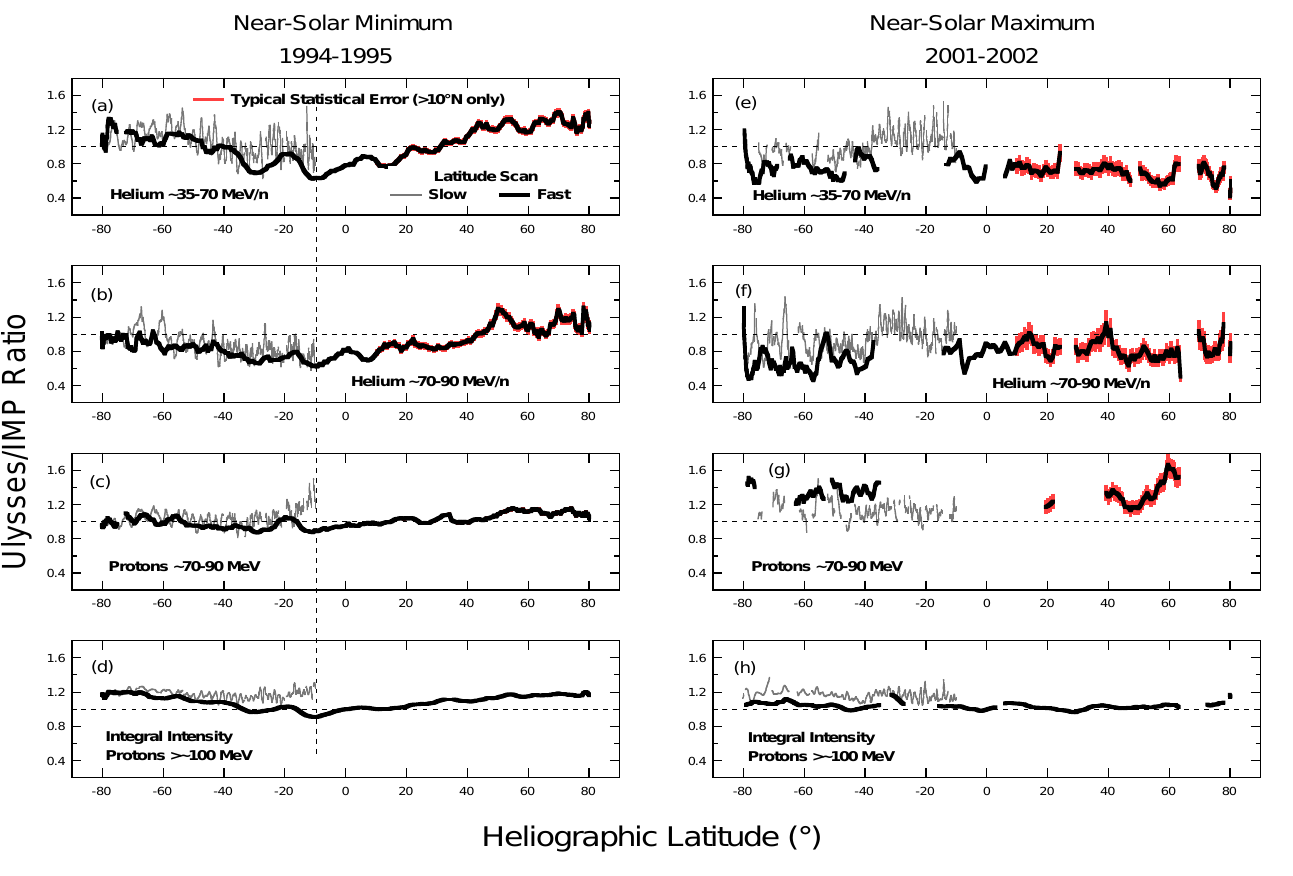
Fig. 2. (a)–(d) Ratios of fluxes or intensities measured at Ulysses to those measured ate IMP-8 for a variety of particle species as a function of heliographic latitude near solar minimum in 1994–95. Light line: slow latitude scan from aphelion near Jupiter’s orbit. Heavy line: Fast Latitude Scan passing from 80.2 ◦ S through perihelion near the equator and on to 80.2 ◦ N within about one year. Typical statistical uncertainties on the flux ratio are shown in red. For clarity, the uncertainties are shown only for latitudes northward of 10 ◦ N. Uncertainties at other latitudes would be similar. During this period, the uncertainties were less than or at most barely greater than the width of the line. (e)–(h) The same for the Fast Latitude Scan near solar maximum in 2001–2002. The larger uncertainties reflect the lower statistics resulting from the much lower fluxes observed near solar